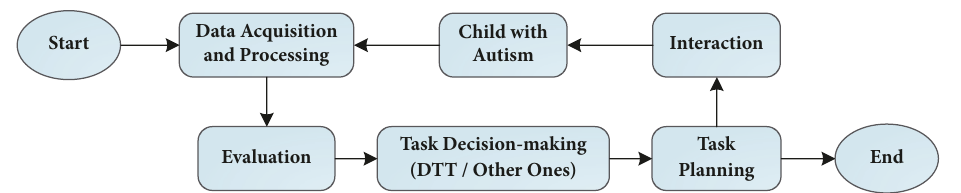
Figure 4: The flowchart of the robot intervention for children with